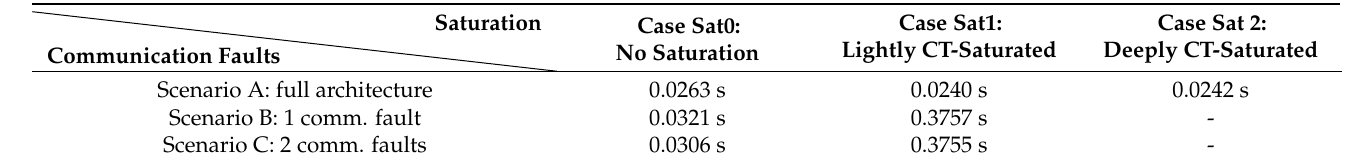
Table 13. Mean trip times obtained for CT saturation tests for 3-phase-to-ground